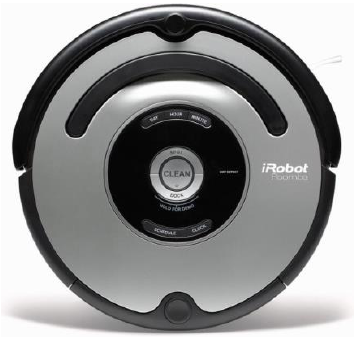
Figure 4. Smart vacuum cleaner as the test product.